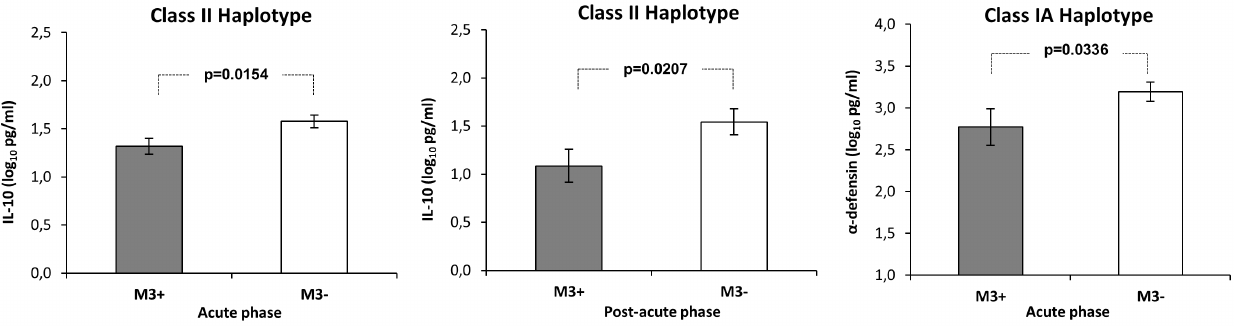
Figure 6. Effects of MHC class I A and II haplotypes on IL-10 and a -defensin production during SHIV SF162P4cy infection. Mean values with standard error are depicted for all animals positive or negative for the indicated haplotype: M3 (n=9) non-M3 (n=12) class I A ; M3 (n=13) non- M3 (n=8) class II.